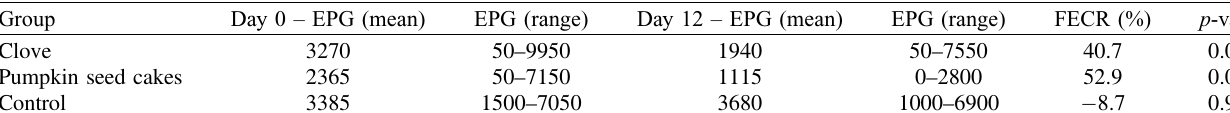
Table 4. Strongylid faecal egg counts in eggs per gram (EPG) and percentage reductions in faecal egg counts (FECR). Group